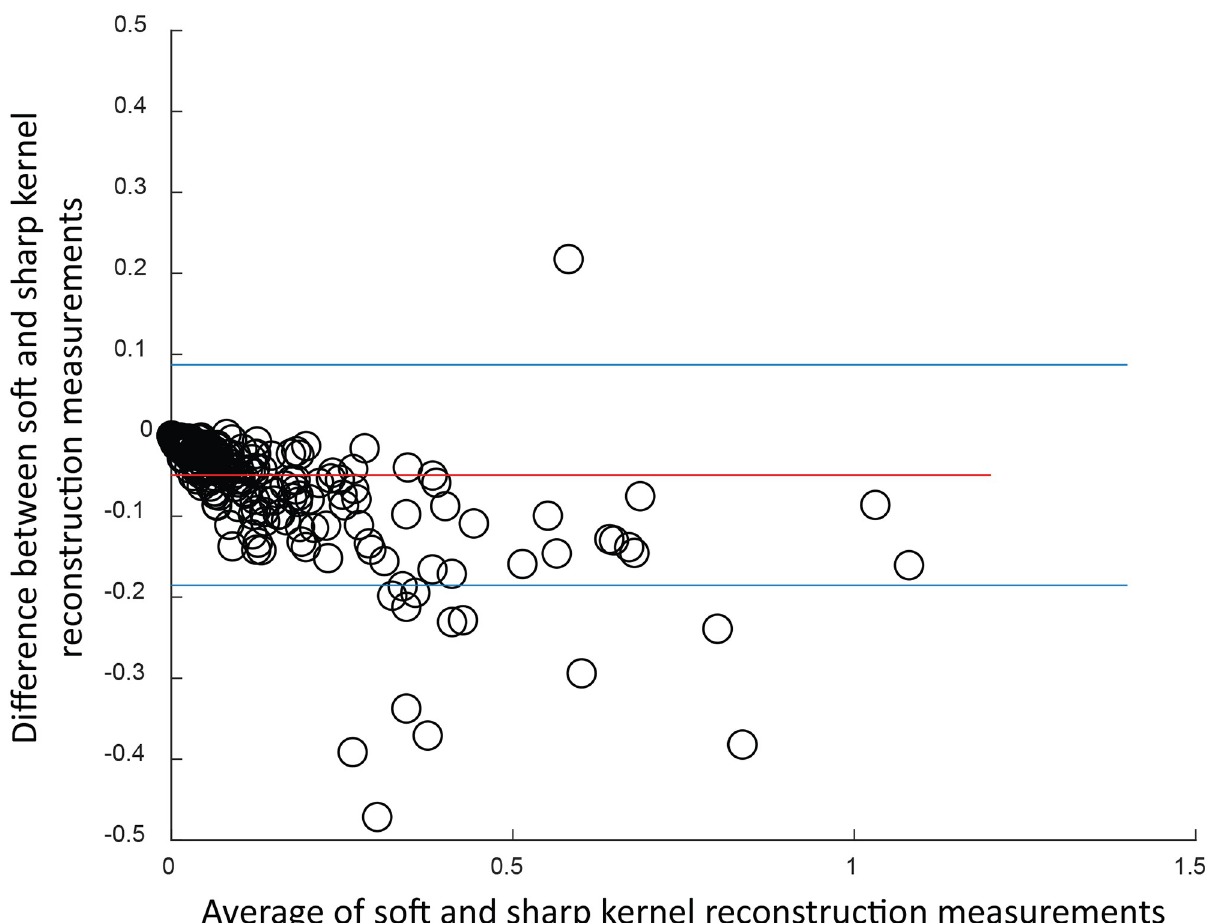
Fig 10. Bland-Altman plot for calcium volume scores calculated with C-CS by using soft vs. sharp reconstruction kernels. Bias is -0.049 with limits of agreement [-0.185, 0.087].